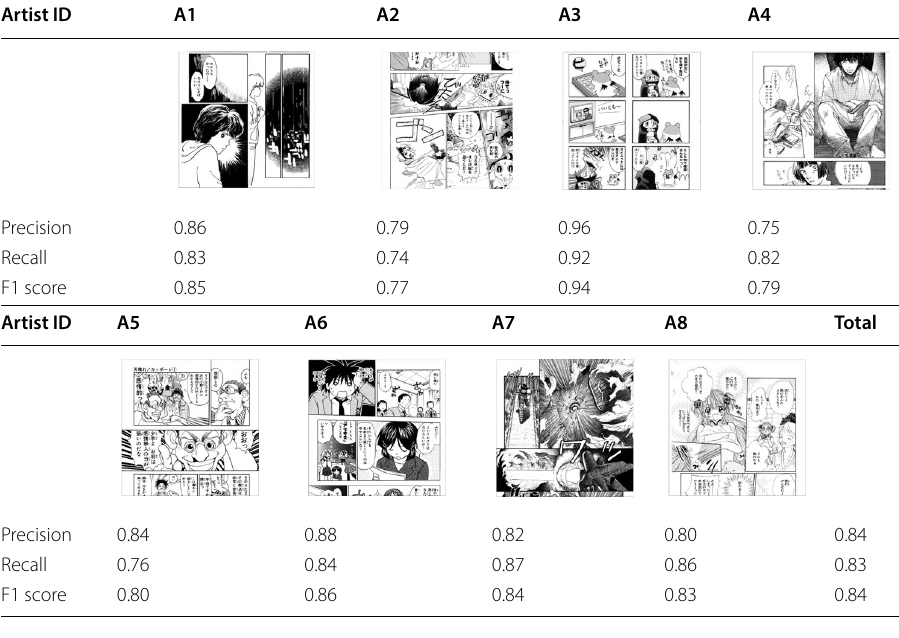
Table 3 Classification performance for the entire page format